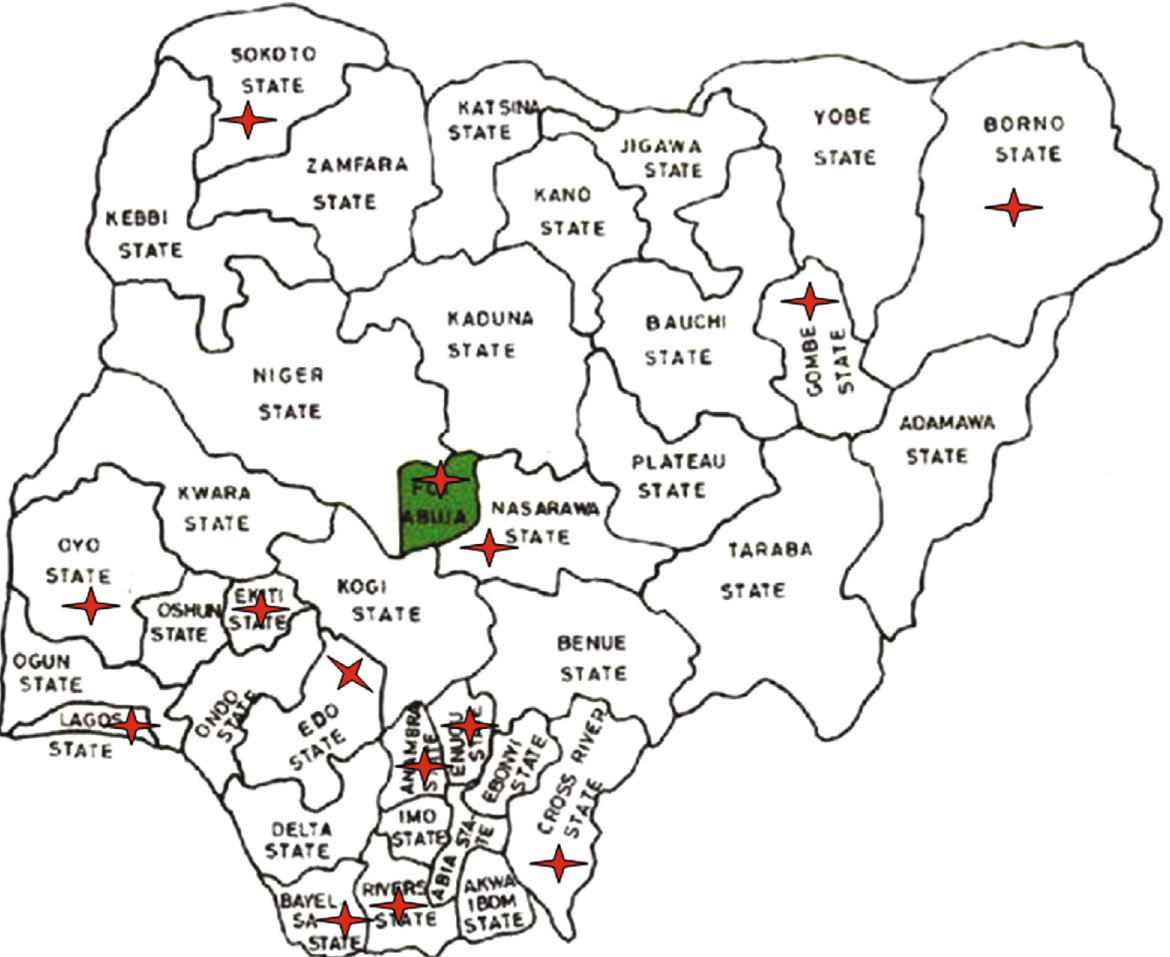
Figure 1: Map of Nigeria showing the location of 15 cancer registries that contributed data to this report (adapted from cancer in Nigeria 2009-2016